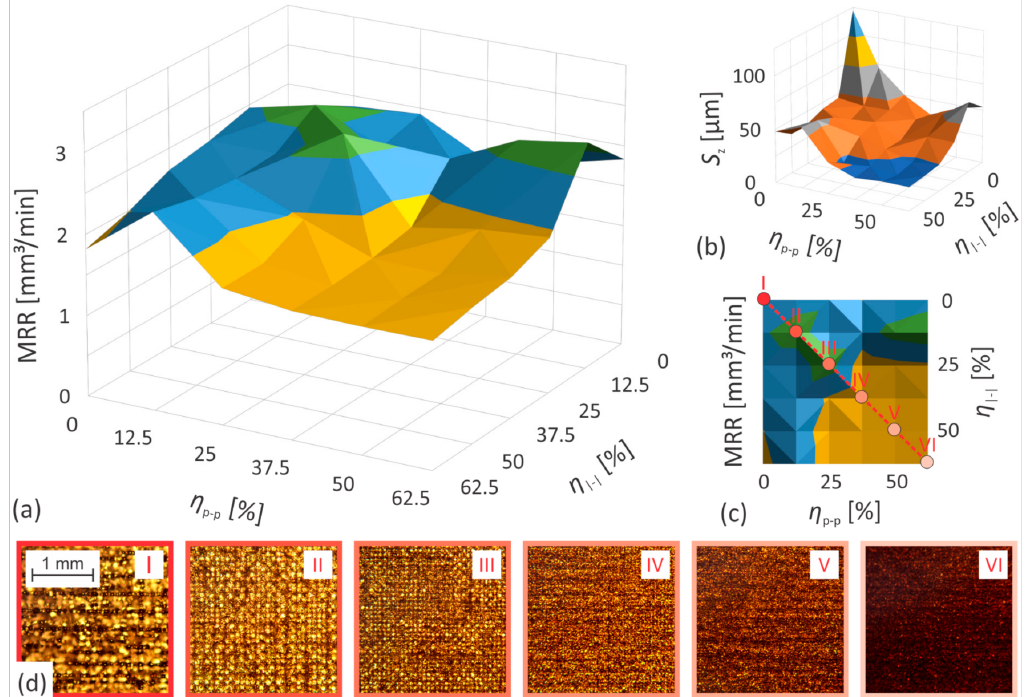
Figure 10. The evolution of ( a , c ) MRR and ( b ) surface roughness as a function of pulse-to-pulse and line-to-line overlap when processing steel AISI 316L; ( d ) bottom of ablated areas acquired by an optical microscope using overlaps as they are marked with dots and Roman numerals on ( c